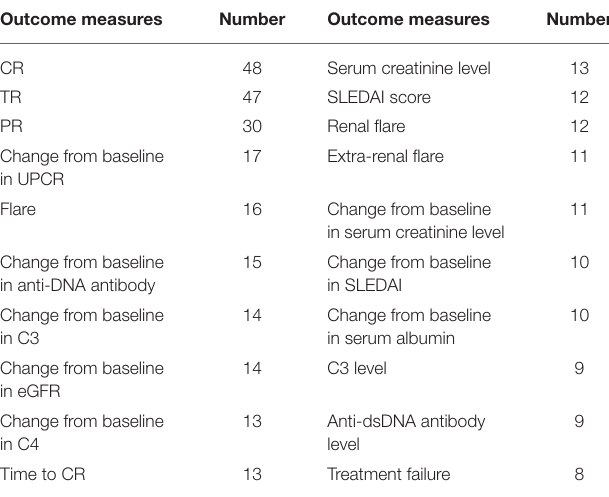
TABLE 3 | The top 20 primary and secondary outcome